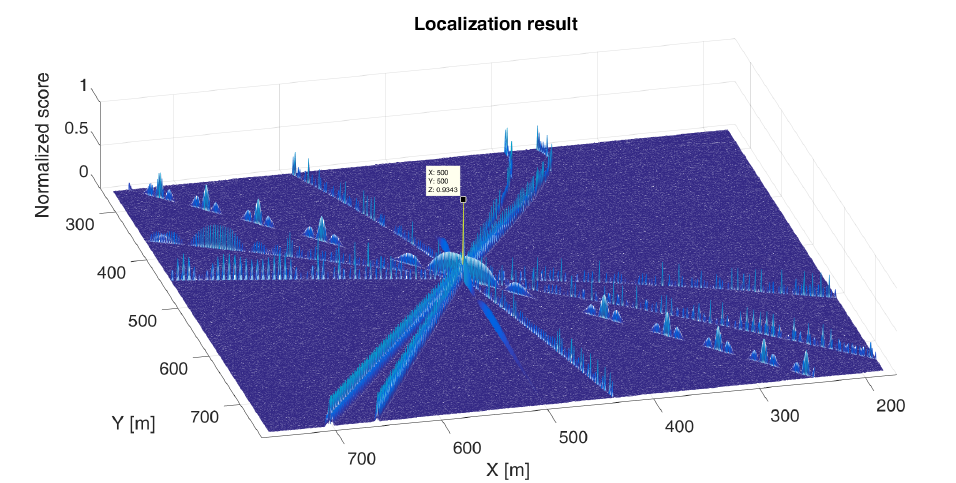
Figure 5. The localization results of one acoustic source in 3D view.